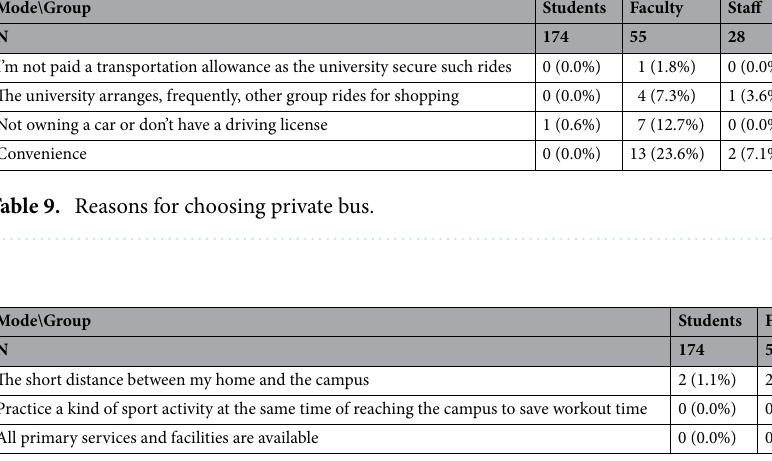
Table 10. Reasons for choosing walking.